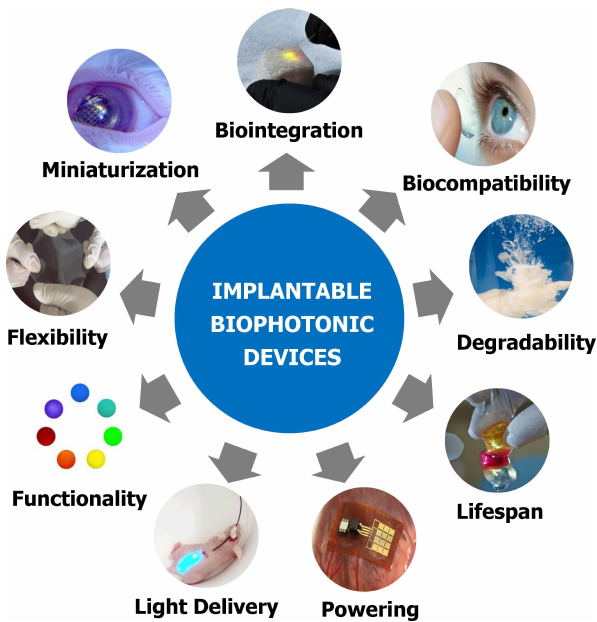
Fig. 11. Factors to consider when designing implantable biophotonic